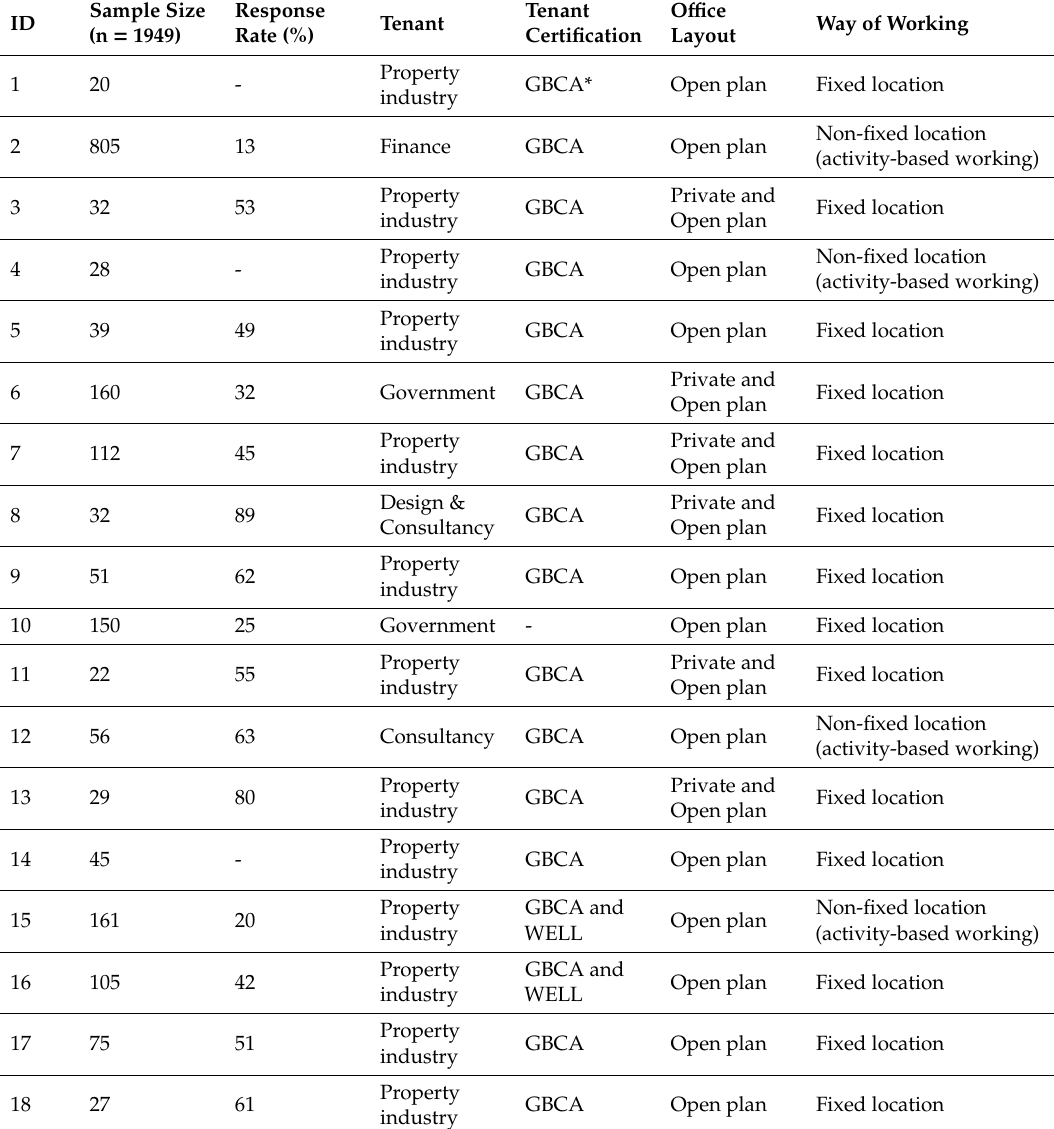
Table 2. Basic information about surveyed o ffi